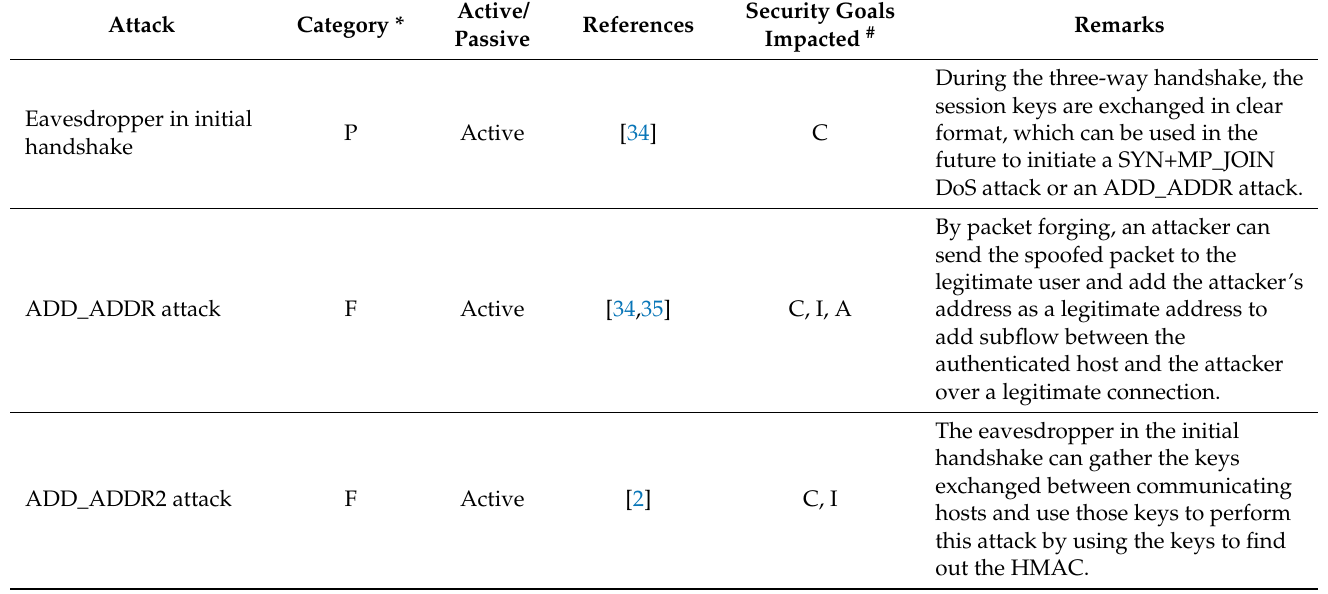
Table 2. Significant threats to MPTCP.